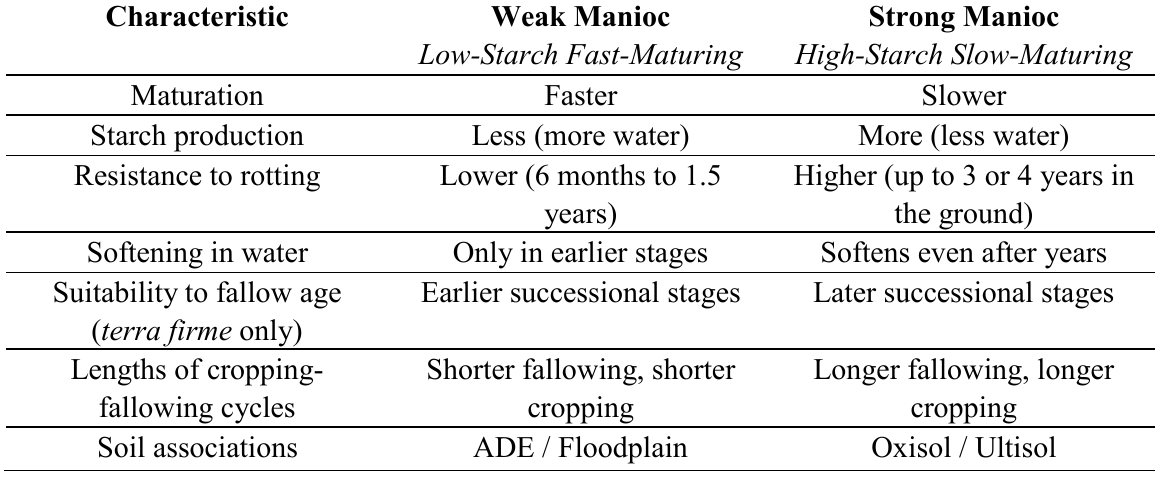
Table 2. Characteristics of weak and strong manioc landraces and their suitability to different ecological contexts according to farmers along the middle Madeira River, in the municipality of Manicoré, Amazonas state,